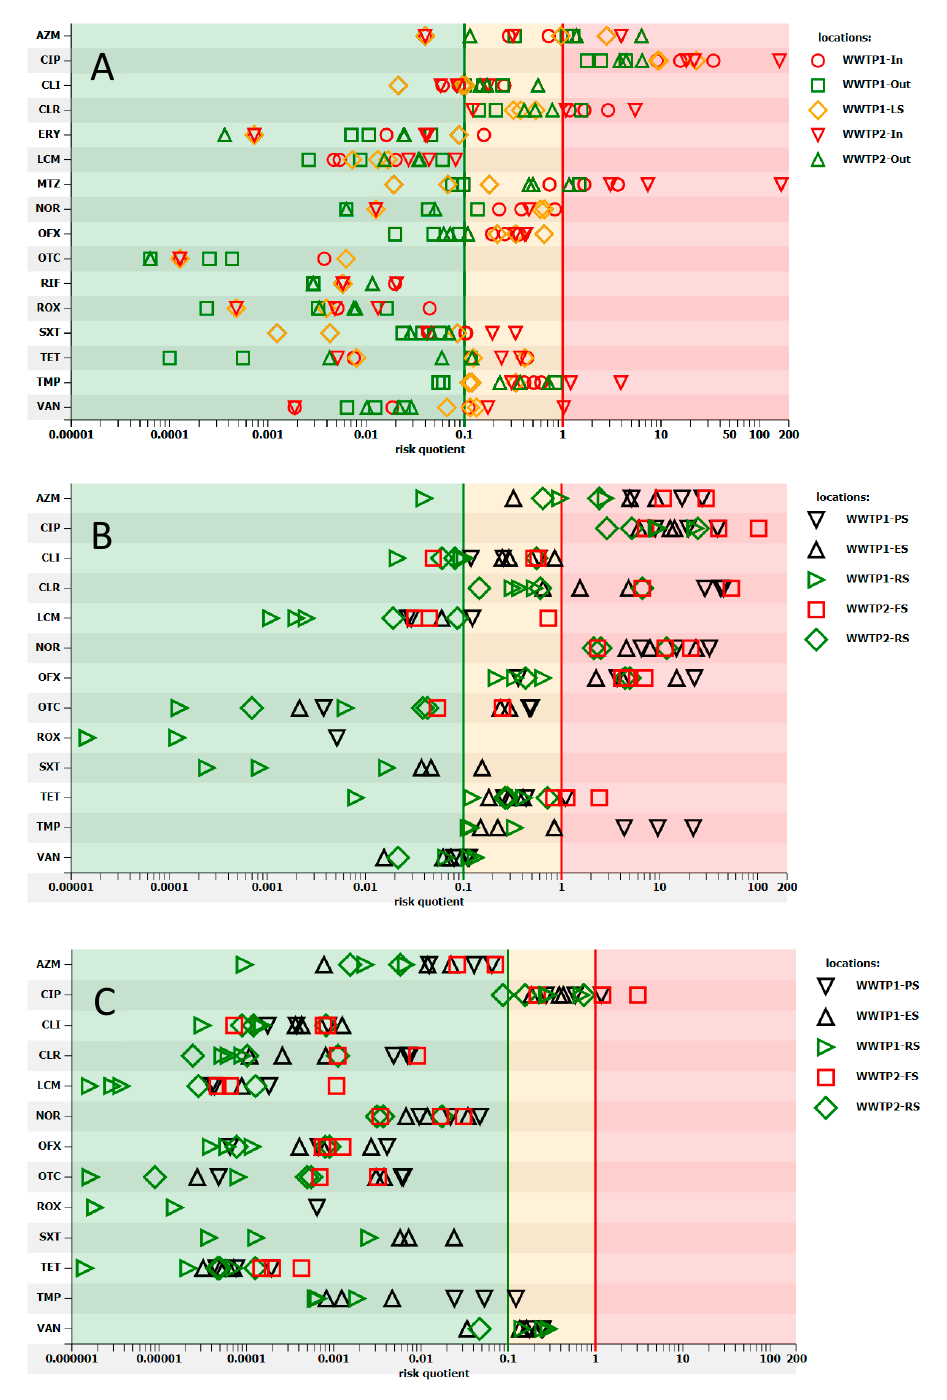
Figure 4. Estimation of risk quotients of resistance selection for the antimicrobials occurring in wastewater ( A ), sludge ( B ), and sludge-amended soil ( C ). Risk quotient below 0.1 indicates minimal risk (green area), between 0.1 and 1 is medium risk (orange area), and over 1 is high risk (red area). ES, excessive sludge; FS, fermented sludge; In, influent; LS, leachate; Out, effluent; PS, primary sludge; RS, residual sludge.